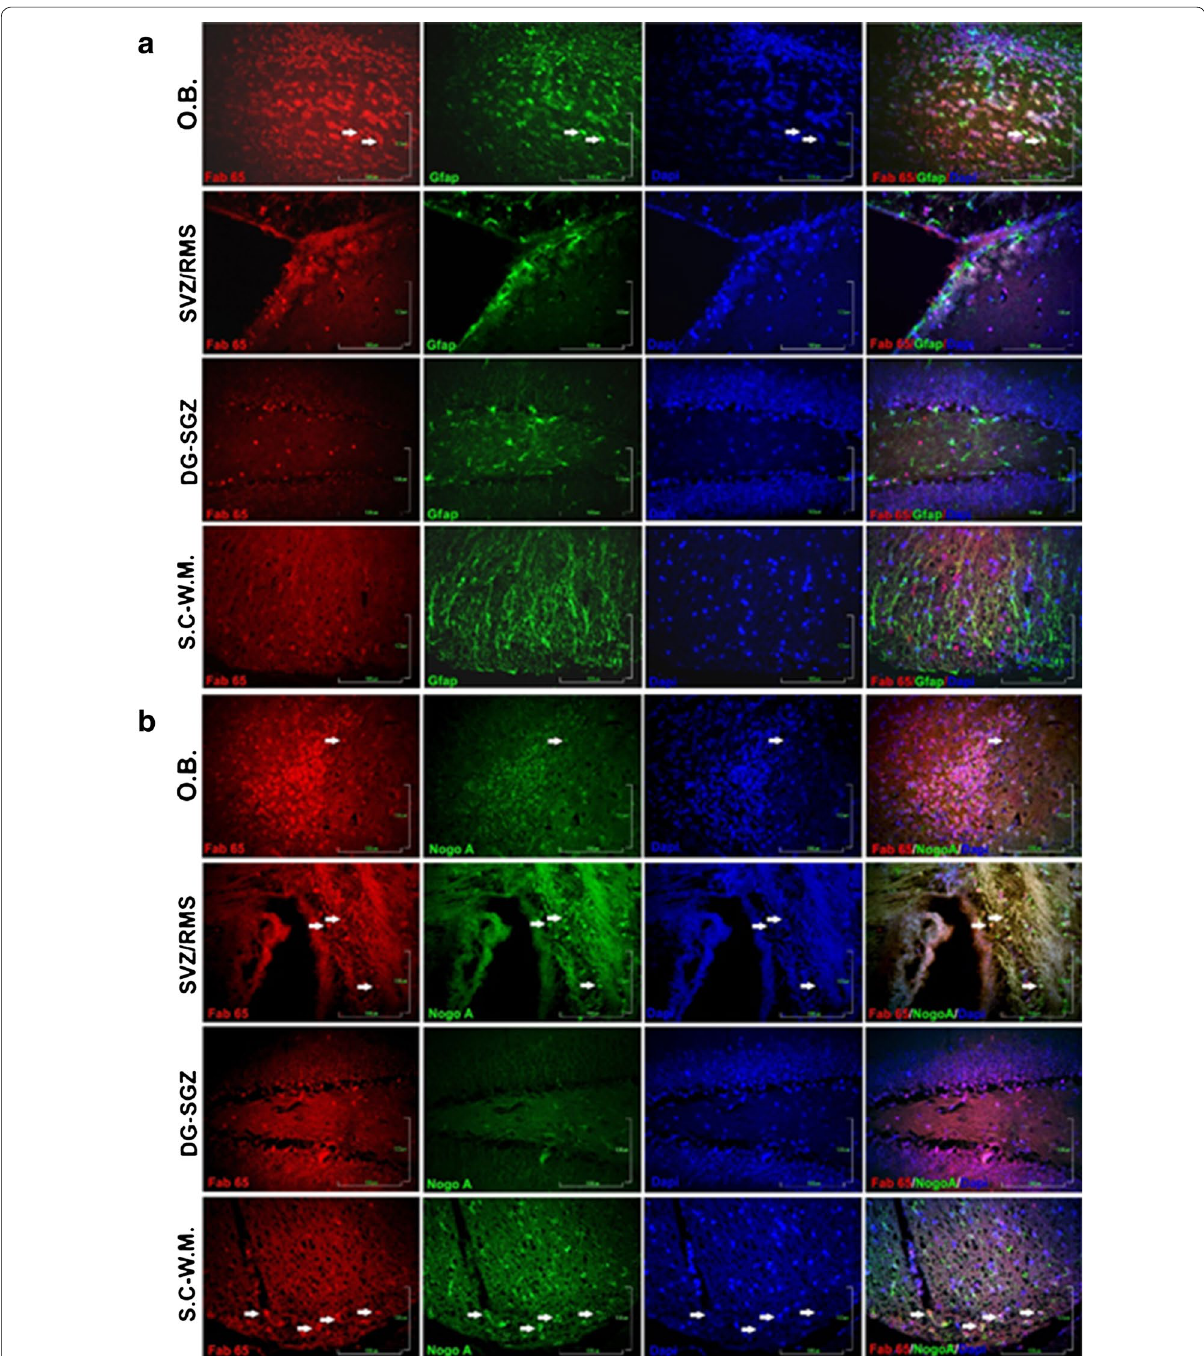
Fig. 5 Double immunofluorescence of different mouse CNS regions probed with recombinant Fab65 and a commercial a GFAP or b Nogo A antibody. O.B.: olfactory bulb, SVZ/RMS: rostral migratory stream of the SVZ, DG-SGZ: subgranular zone of the dentate gyrus, and S.C-W.M.: white matter of the spinal cord. Sections probed with Fab 65 (red) and anti-GFAP or anti-NOGO A (green). Arrows indicate representative cells with observed co-expression of the Fab 65 recognised antigen(s) with GFAP. Cell nuclei were stained with DAPI. Scale bars